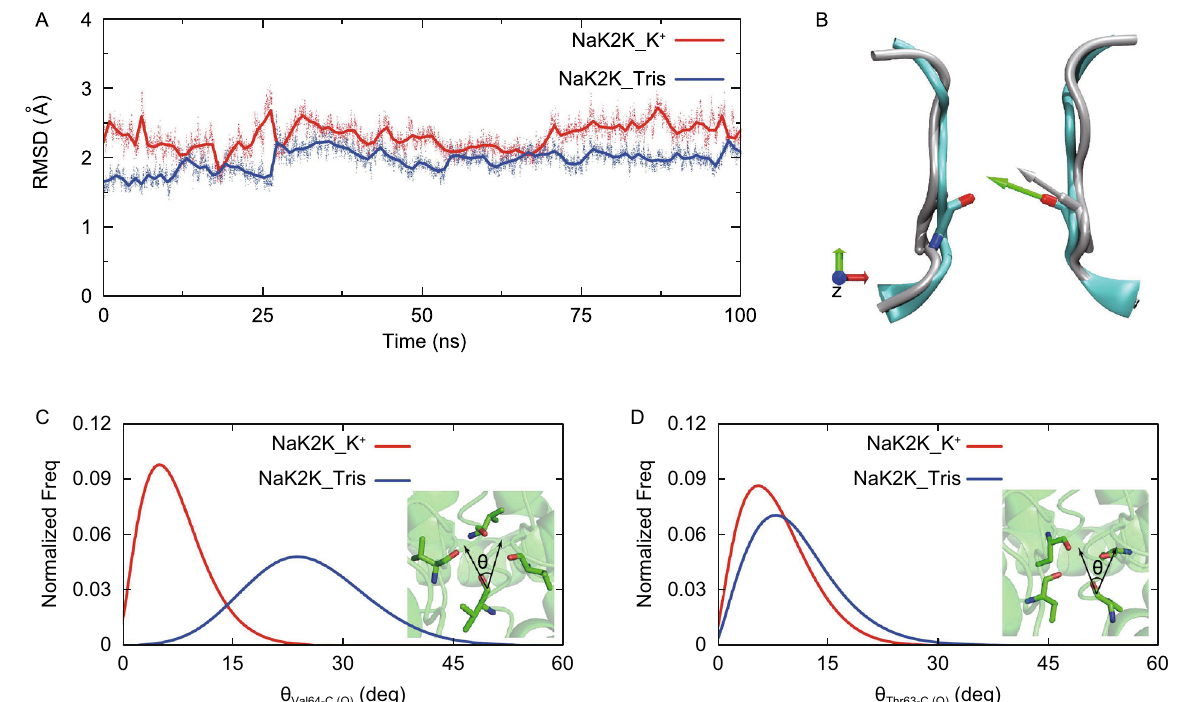
Figure 2. Dynamics of the NaK2K Val64 carbonyl groups during K + binding process . (A) RMSD of the NaK2K_K + and NaK2K_Tris systems during MD simulation. (B) θ Val64-C(O) angle was formed by the two C=O vectors from MD simulations (grey) and the reference crystal structure (cyan). (C) Distribution of θ Val64-C(O) in NaK2K_K + system (red) and in NaK2K_Tris system (blue). (D) Distribution of θ Thr63-C(O) in NaK2K_K + system (red) and in NaK2K_Tris system